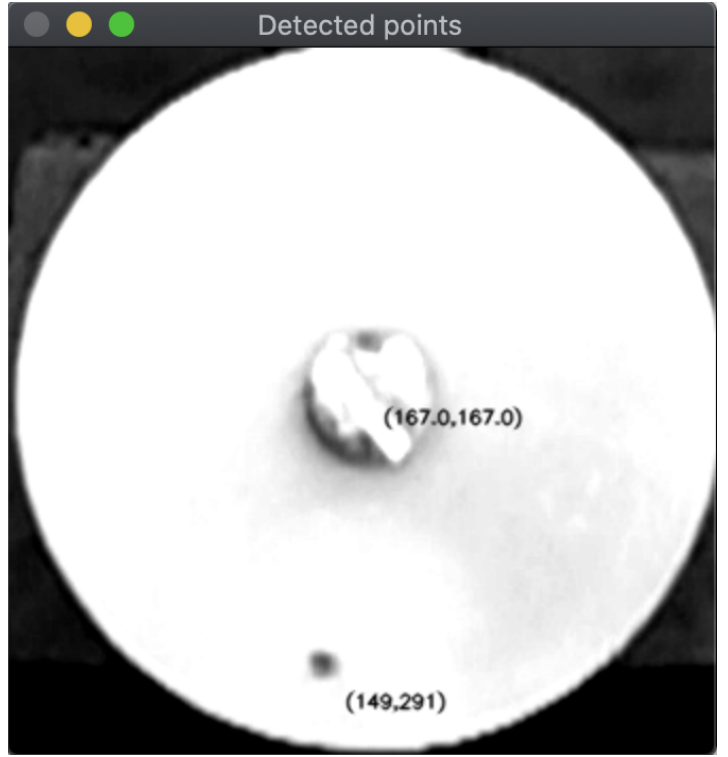
Figure 3. Identifying the target points in the grayscale version of the input image. After processing all input images, a text file is generated. This file will contain in each row the name of the input image and the ( x , y ) coordinates of the center and the red dot, respectively, with a blank space separating them. An example of part of such text file is presented in Listing